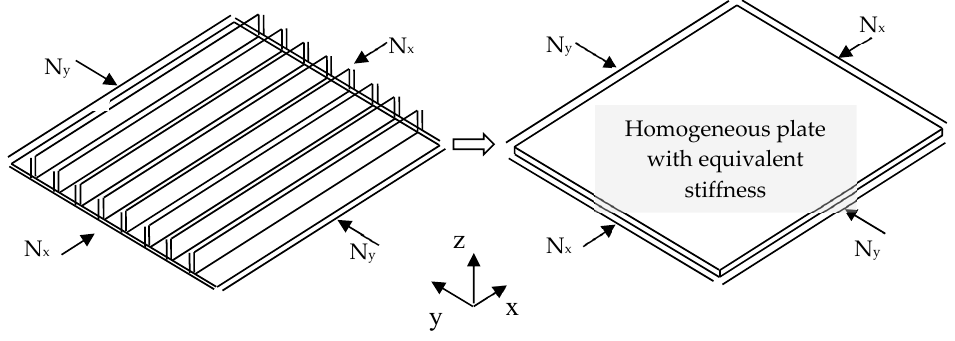
Figure 4. Homogenization of a stiffened panel by smearing stiffeners.